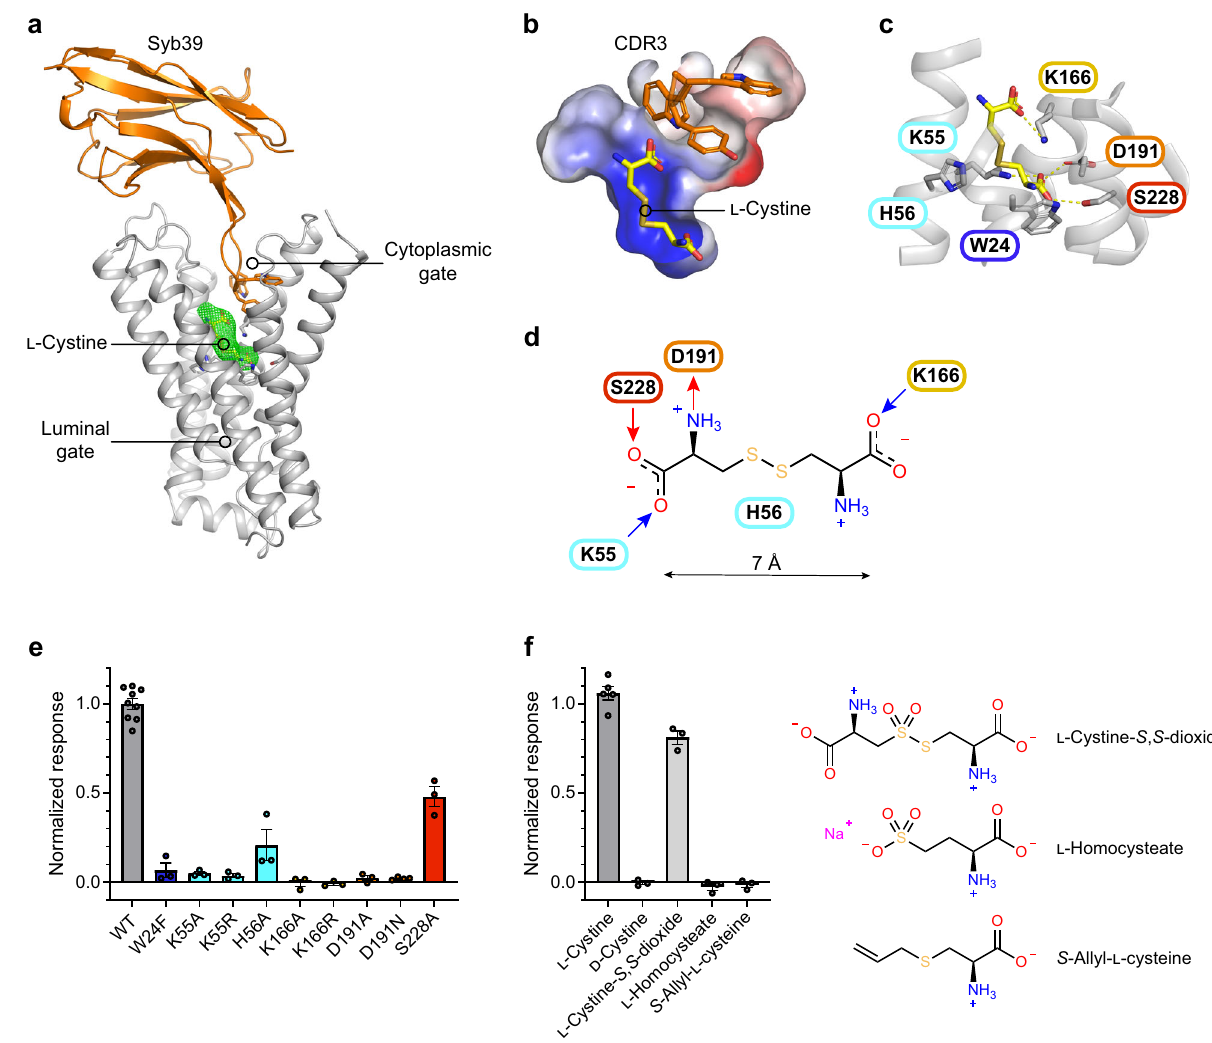
Fig.2|Structuralbasisfor L -cystinerecognition.a Crystalstructureofcystinosin showing sybody 39, which aided in trapping the cystine ligand within the binding site. Cystine mFo-DFc difference electron density map (green mesh) contoured at 3 σ . b The central binding site is positively charged complementing the negative charge on cystine. c Zoomed in view of the binding site showing the interaction network between cystinosin and cystine. d Schematic of cystine highlighting key interactions in the binding site. e Impact of binding site variants on cystine